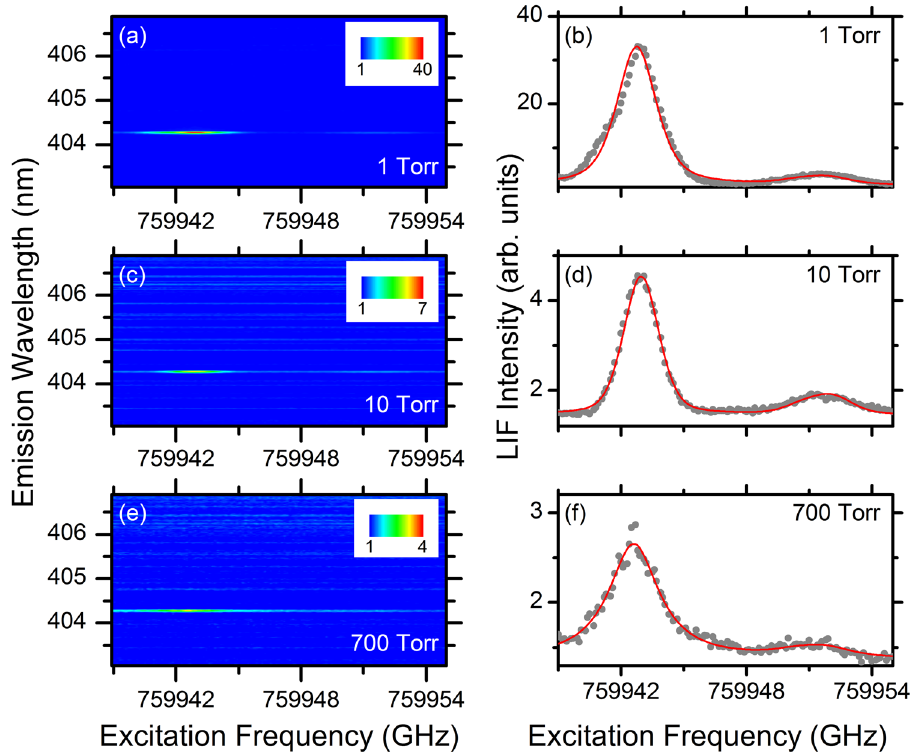
Figure 3. Dependence of uranium LIF emission on the pressure of the ambient Ar atmosphere. 2DFS (left) and LIF emission intensity (right) for NU sample as a function of pressure. Ar pressures are ( a , b ) 1 Torr, ( c , d ) 10 Torr, and ( e , f ) 700 Torr. Experimental data is shown as gray points and the spectral fit is shown as the solid red